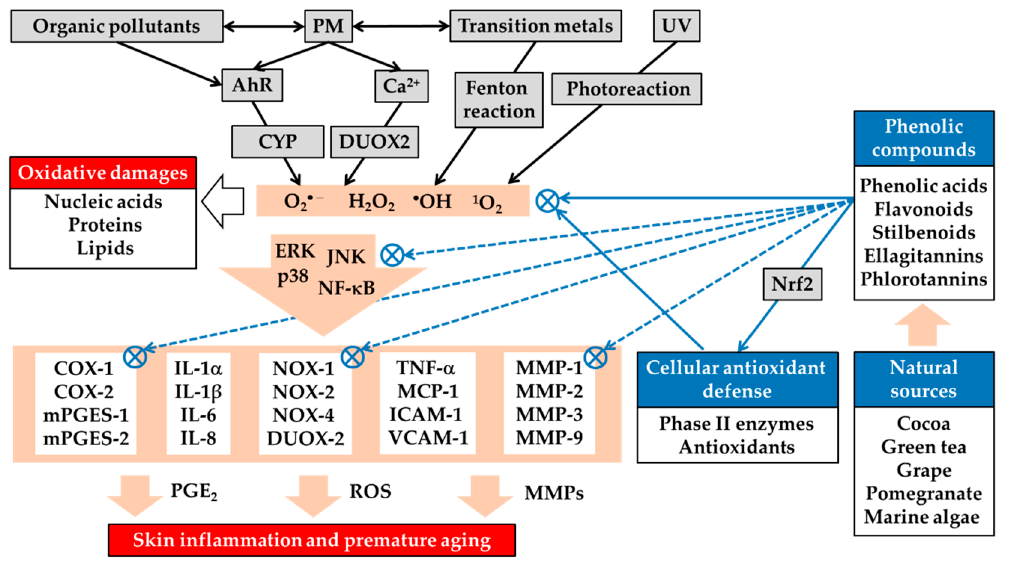
Figure 2. Airborne PM-induced oxidative stress in the skin and its attenuation by plant-derived phenolic antioxidants. PM stimulates the generation of ROS, such as superoxide anion radical (O 2 • − ), hydrogen peroxide (H 2 O 2 ), hydroxyl radical ( • OH), and singlet oxygen ( 1 O 2 ), by mechanisms that include the AhR / cytochrome P-450 (CYP) pathway, calcium (Ca 2 + ), and dual oxidase 2 (DUOX2)-dependent mechanisms, as well as Fenton reaction catalyzed by transition metals and photochemical or photodynamic reactions resulting from ultraviolet radiation (UV). PM-induced ROS can cause oxidative damage to nucleic acids, proteins, and lipids and activate multiple signaling pathways, such as the extracellular signal-regulated kinase (ERK), c-Jun N-terminal kinase (JNK), p38 mitogen-activated protein (MAP) kinase, and nuclear factor (NF)- κ B, linked to gene expression of inflammatory mediators, such as cytokines, chemokines, cell adhesion molecules, and matrix metalloproteinases (MMPs), and synthesis of prostaglandin (PG) E 2 . Many plants, such as cocoa, green tea, grape, pomegranate, and some marine algae, are rich sources of phenolic acids, flavonoids, stilbenoids, ellagitannins, phlorotannins, and other phenolic compounds. These phenolic compounds can directly scavenge ROS from various sources and can enhance the cellular antioxidant capacity by Nrf2-dependent mechanisms. Through these direct and indirect antioxidant activities, the phenolic compounds can suppress the redox-sensitive signaling pathways leading to the gene expression of inflammatory mediators. Phenolic compounds can also directly inhibit the catalytic activity of protein kinases in the signaling pathways and other metabolic enzymes involved in ROS generation, prostaglandin synthesis, and extracellular matrix degradation. Plant-derived phenolic antioxidants can thereby alleviate oxidative stress and inflammatory skin diseases, such as atopic dermatitis and acne vulgaris, and premature skin aging caused by PM. Some phenolic compounds can increase or decrease AhR-dependent downstream gene expression, and can have positive or negative e ff ects on skin health. NOX, NADPH oxidase; COX, cyclooxygenase; mPGES, microsomal prostaglandin E 2 synthase; IL, interleukin; TNF, tumor necrosis factor; MCP, monocyte chemoattractant protein; ICAM, intercellular adhesion molecule; VCAM, vascular cell adhesion